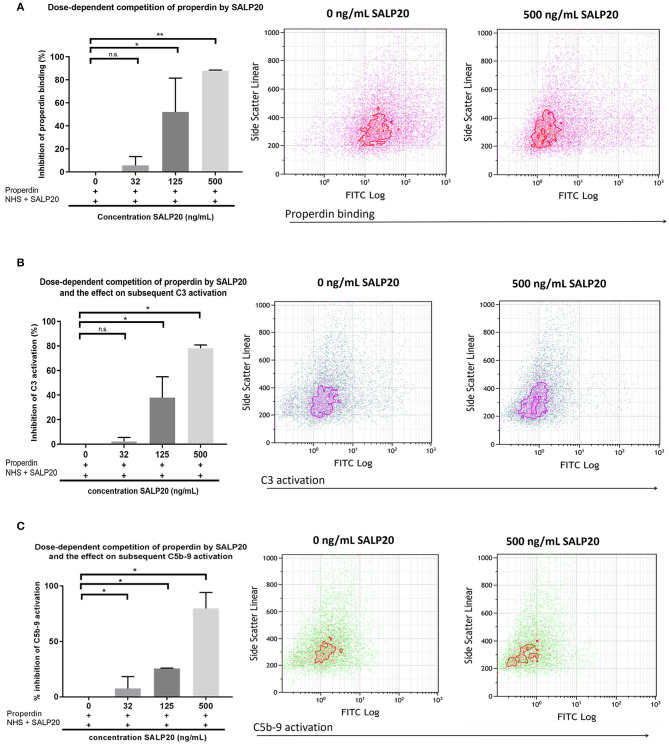
Recombinant Salp20 dose-dependently competes with HK-2 bound properdin, thereby preventing AP complement activation. (A) PTECs were incubated with purified properdin followed by incubation with NHS and increasing concentrations of Salp20. Bars show quantitative analysis of multiple experiments (n = 2). Density plots of a representative experiment show the shift in PTEC-bound properdin in the presence of 500 ng/ml Salp20. (B) C3 activation can be dose dependently inhibited by recSALP20. The same experimental set up as in (A), but now C3 activation was detected. (C) C5b-9 activation can be dose dependently inhibited by Salp20. The same experimental set up as in (A,B), but now C5b-9 activation was detected. Data were analyzed by Mann-Whitney U test with an option of multiple comparison (*P < 0.05, **P < 0.01). Asterisks above the capped lines denote significant differences between the untreated samples and the recombinant Salp20 inhibition with different concentrations.